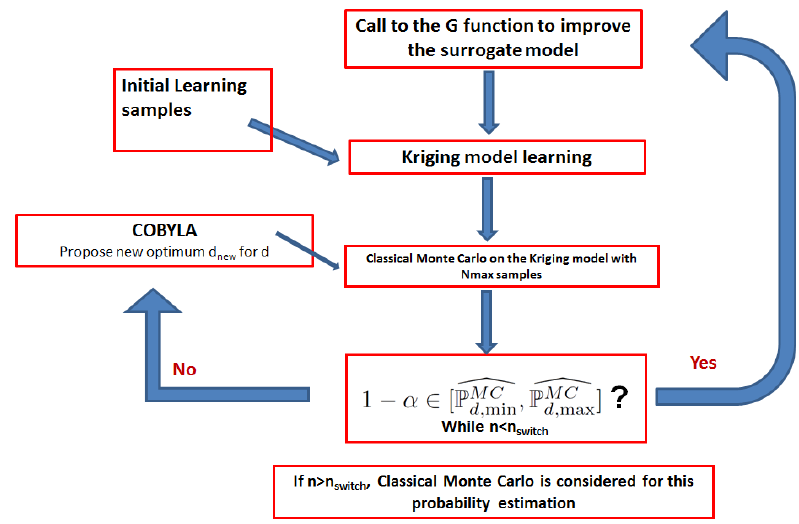
Figure 2. Implementation of the COBYLA/Kriging algorithm.